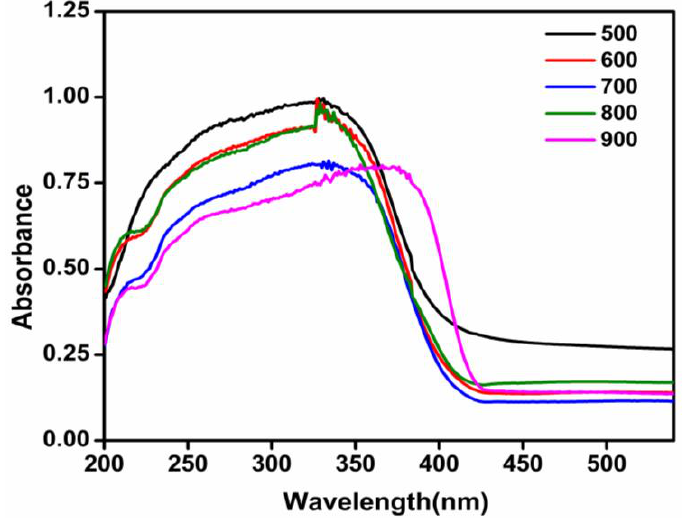
Figure 11. UV-Visible spectra of TiO 2 nanoparticles calcined at different temperatures.